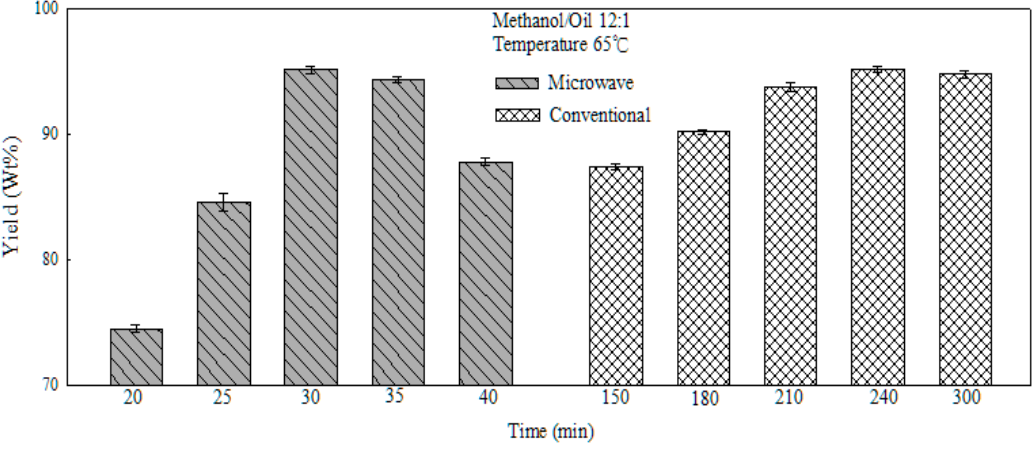
Figure 8. Comparison of biodiesel production using microwave heating and conventional heating.